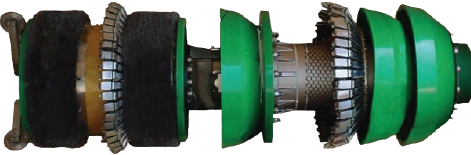
Figure 2. Example of sealing PIG.